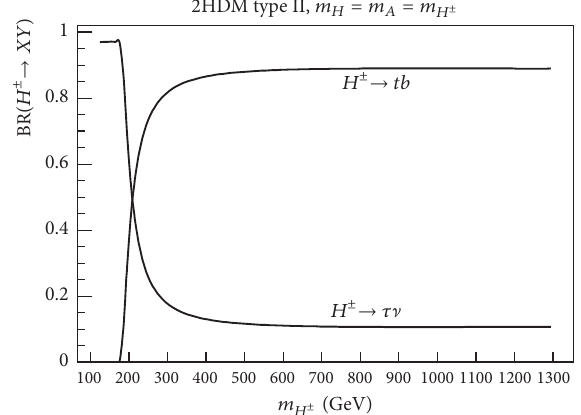
Figure 8: Branching ratio of charged Higgs decays in 2HDM